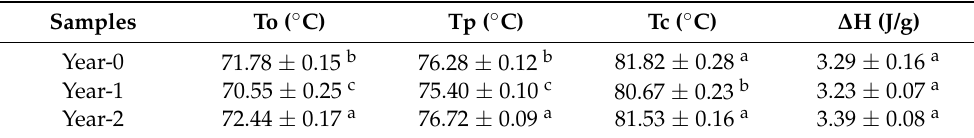
Table 5. Gelatinization parameters of rice starch during storage.